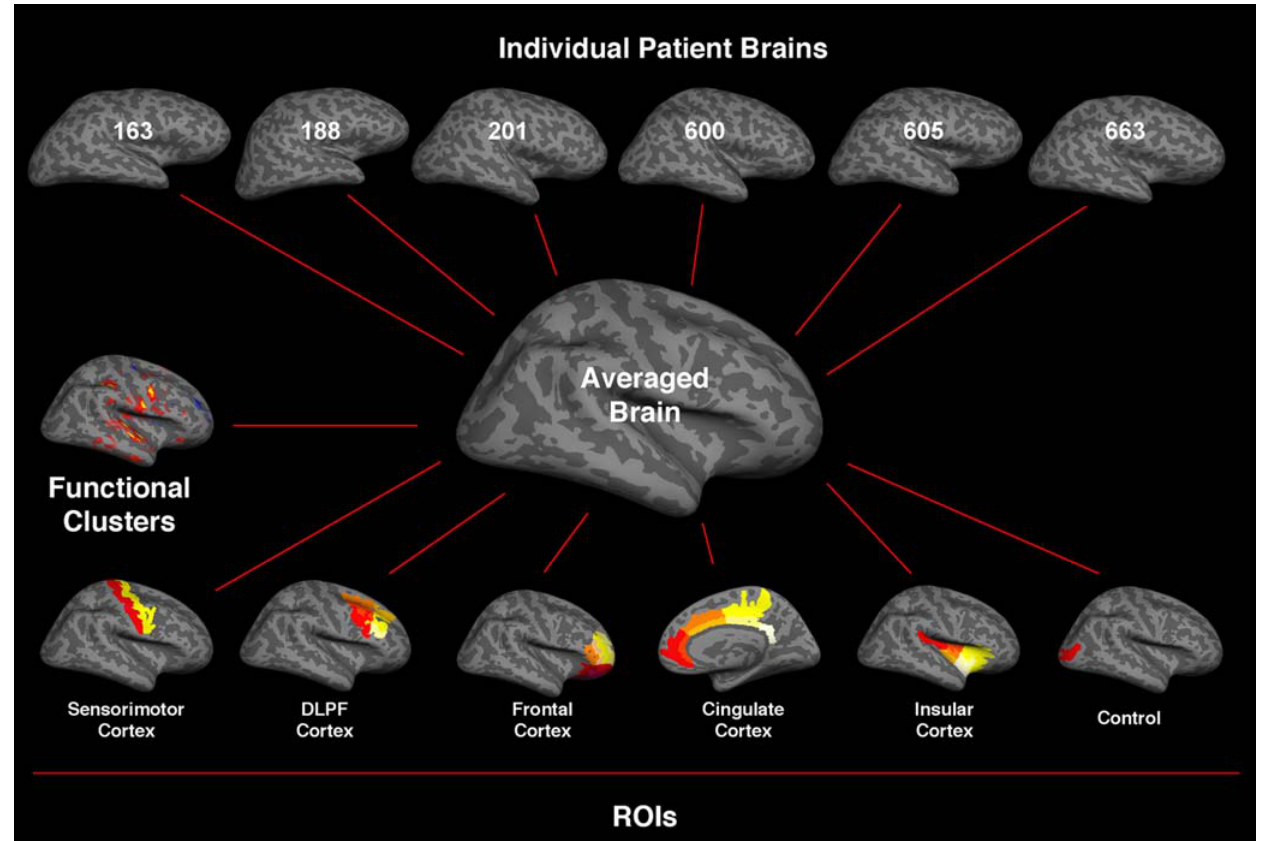
Figure 1. The upper six images show individual inflated brains, exposing sulci and gyri, of trigeminal neuropathic pain (TNP) patients affecting the right maxillary division (V2) of the trigeminal nerve. Each subject was scanned twice, for subsequent functional and structural data averaging, with a minimum of 3–6 months separating the scanning sessions. The middle inflated brain represents the averaged brain of the TNP patients based on the a common spherical atlas for each hemisphere aligning morphologically homologous gyri and sulci from each subject’s brain; The midlle left image illustrates functional (de)activation during V2 allodynic stimulation, and the lower six images show regions of interest (ROIs) parcellated from the averaged to the individual brains independently. Subsequently, the cortical thickness differences (TNP versus healthy controls, and contralateral versus ipsilateral sides to the TNP (see Data S1) and underline functional activity where analyzed in five specific cortical ROIs. In addition, the Occipital Middle Sulcus was selected as a control cortical